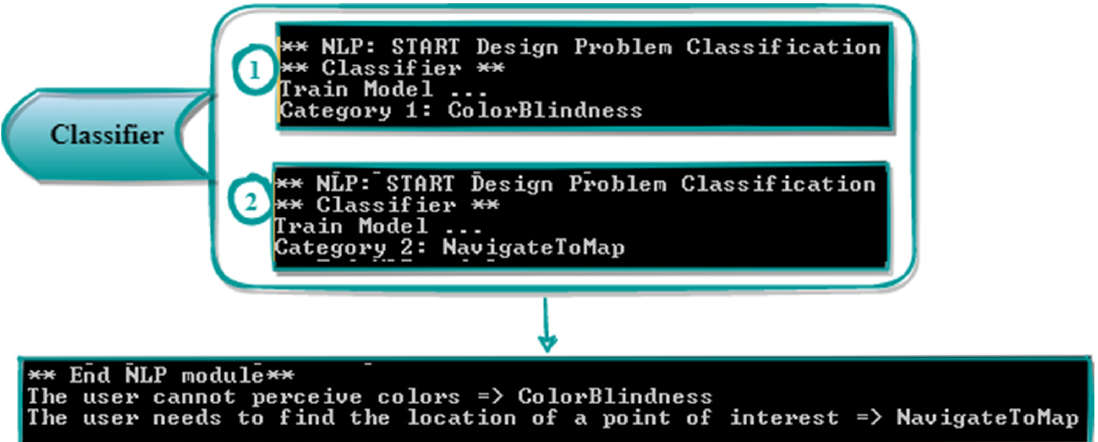
Figure 10. Classifier results for DPS-1. Appl. Sci. 2021 , 11 , x FOR PEER REVIEW